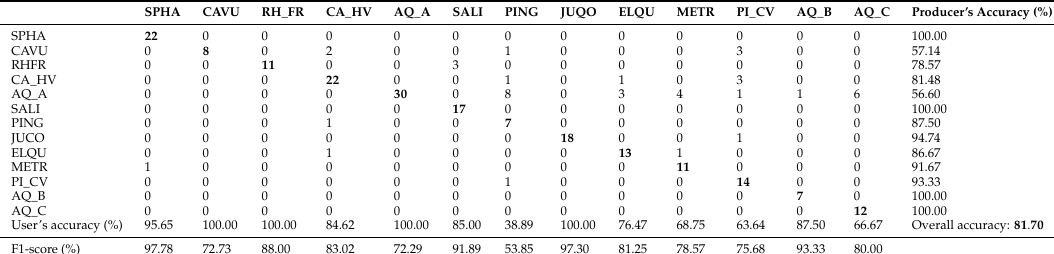
Table 10. Confusion matrix of the classification based on Second derivative, Canberra Distance on [350–2500 nm] with Median reflectance as reference spectral database. The producer’s and user’s accuracies, the overall accuracy and the F1-score are also